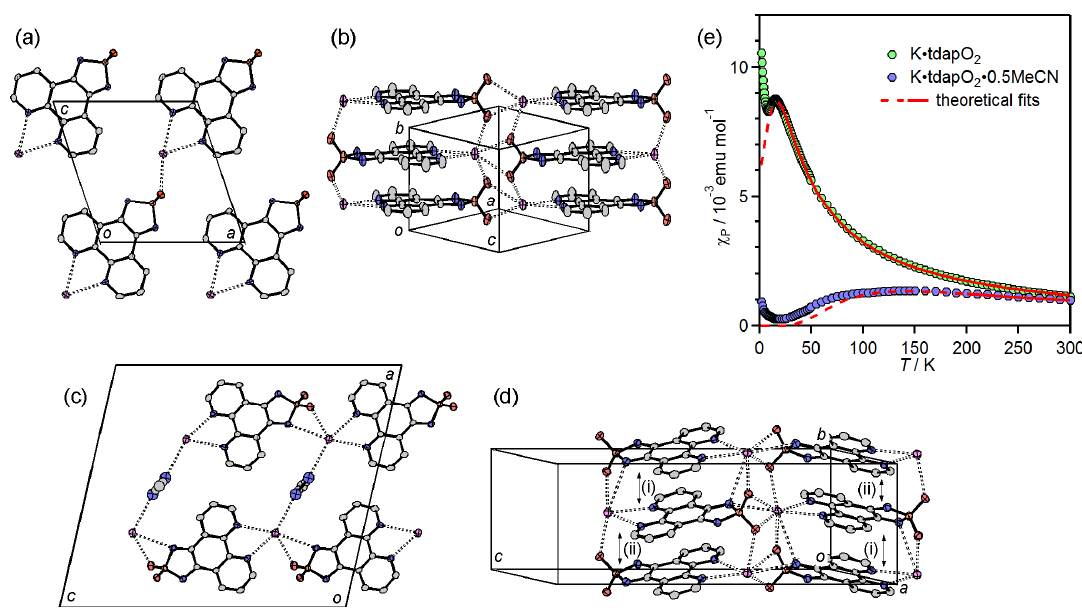
( a , b ) and K•tdapO •0.5MeCN ( c , d ). Temperature 2 2 for K•tdapO and K•tdapO •0.5MeCN ( e ). Adapted with p 2 2